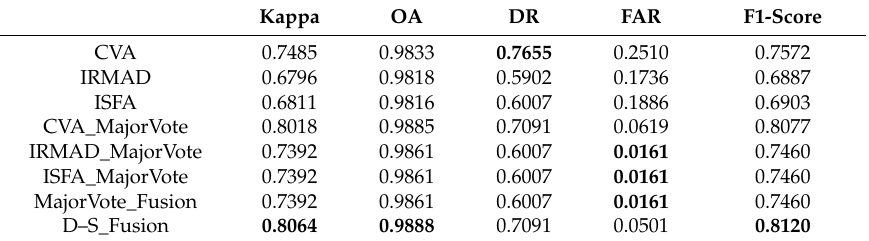
Table 4. Quantitative evaluation of the proposed method and comparative methods in test dataset 2.